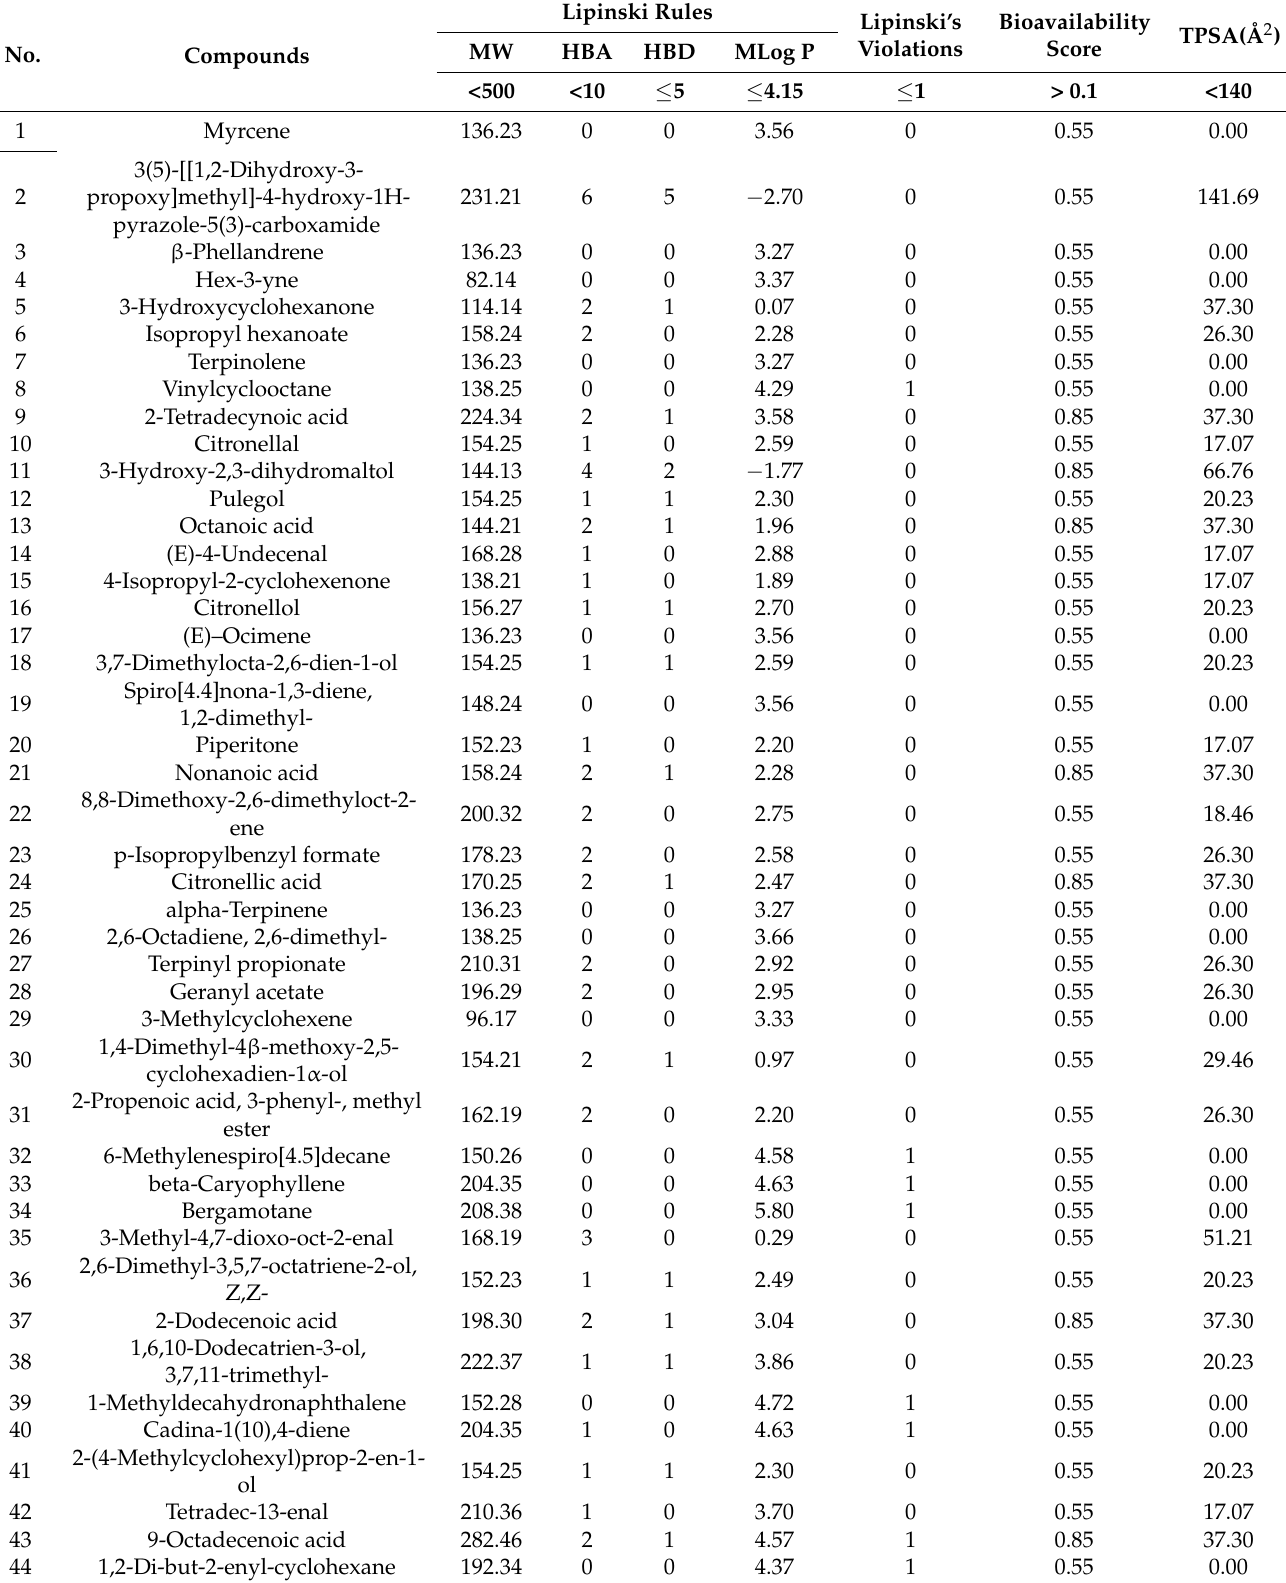
Table 2. Physicochemical properties of chemical compounds for good oral bioavailability and cell membrane permeability.